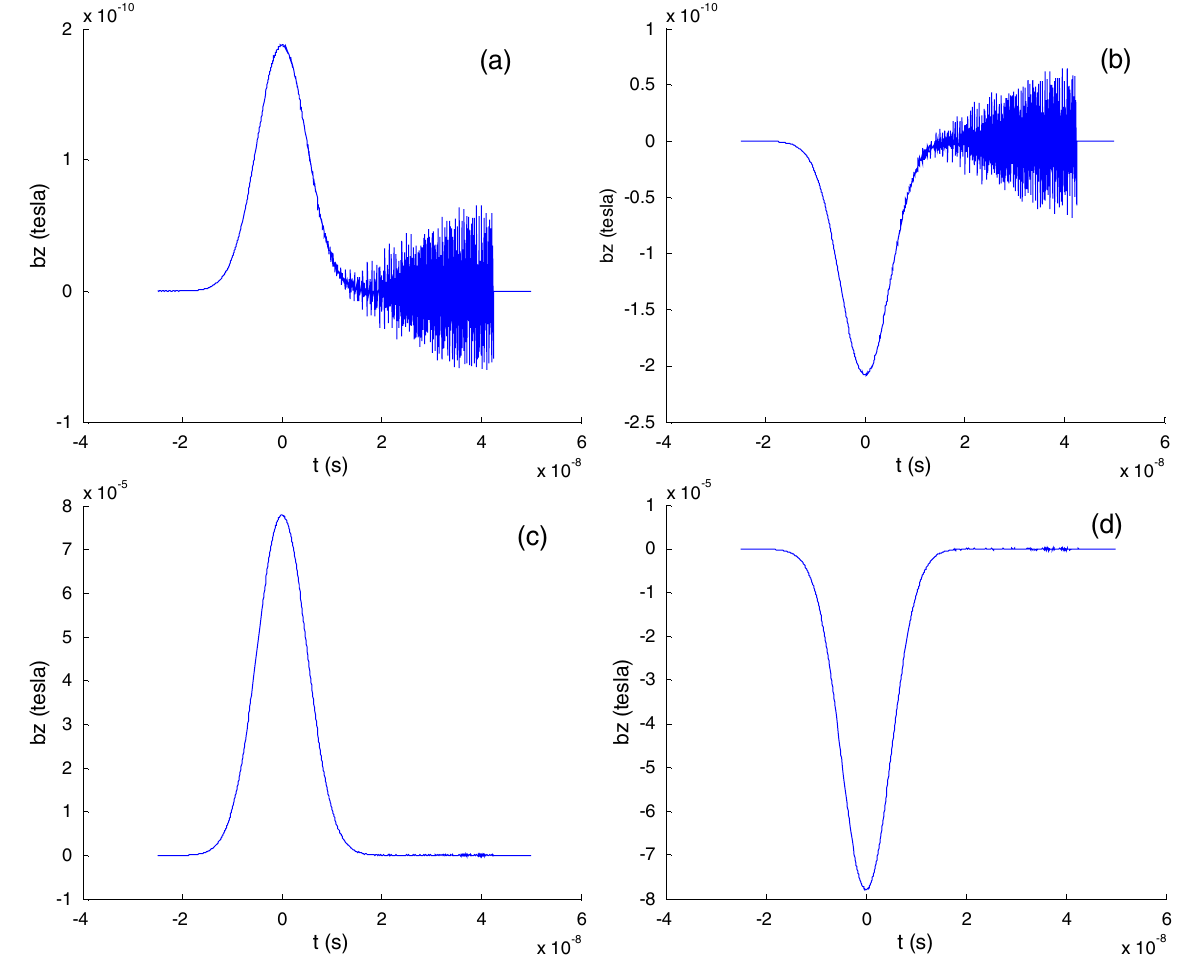
FIG. 7. (a) B at x ¼ b , y ¼ 0 ; (b) B z beam pipe. For all four plots z ¼ 5 : 25 m .